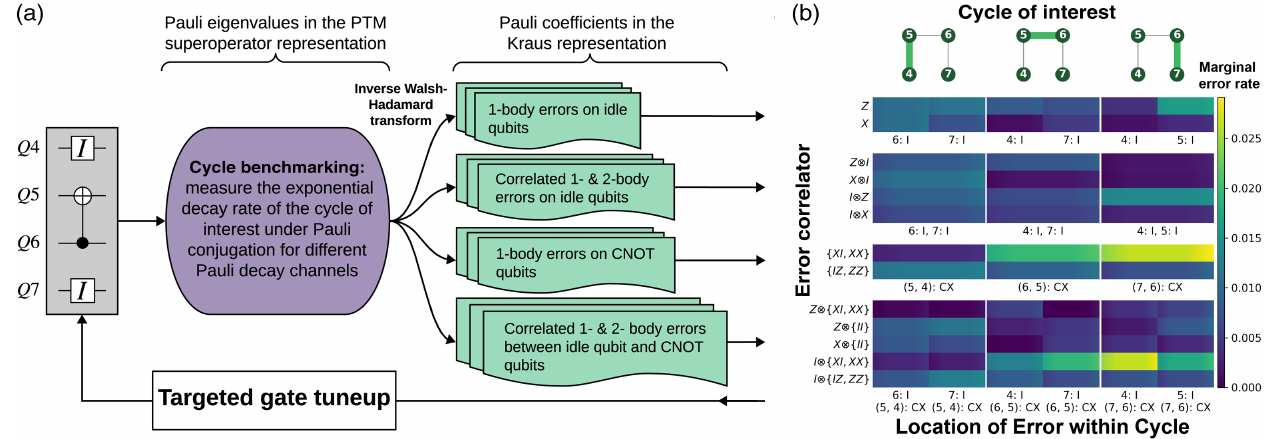
FIG. 2. Cycle error reconstruction of the tailored noise under cycle benchmarking. (a) Schematic of the process by which one- and two-body gate errors can be reconstructed using targeted CB measurements of a parallel gate cycle (e.g., CNOT between Q5 and Q6, with Q4 and Q7 idling), providing detailed information about the Pauli (Kraus) errors occurring during the cycle, as shown in panel (b). (b) Cycle error reconstruction results of four-qubit cycles containing a single CNOT gate and identity gates on the spectator qubits. The y axis ( x axis) labels the type of error (where the error occurs in the cycle), and the color (gradient) indicates the marginal error rate from all Pauli contributions (95% confidence interval). The first (third) row of subplots shows one-body errors acting in idling (CNOT) qubits, the second row of subplots shows correlated one- and two-body errors between idling qubits, and the last row of subplots shows correlated one- and two-body errors between an idling spectator qubit and qubits participating in the CNOT. Here, a k -body error is labeled by k nonidentity gates acting on n qubits (e.g., k ¼ 1 for CNOT qubits, because these errors occur within a single gate body acting on two qubits). Curly brackets indicate error types that cannot be distinguished due to degeneracies since any local error acting on either qubit in the entangling operation will be transformed by the CNOT. All rows in which all errors are below 30% of the maximum value have been omitted for clarity. This detailed information can be used to perform targeted gate tuneup to address the most harmful errors. The residual errors in our system are broadly distributed among many pathways, so any further targeted tuneup will come with diminishing